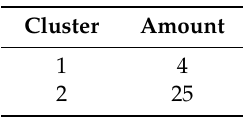
Table 2. Clustering